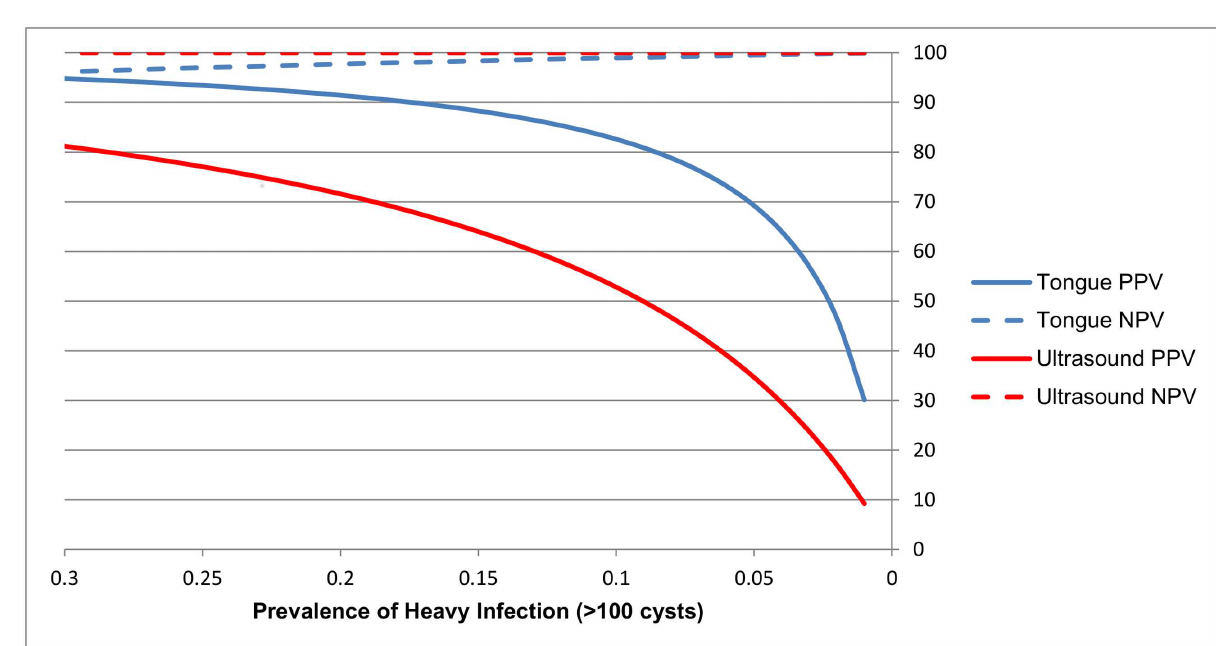
Fig 2. Positive and negative predicted values for the detection of heavily infected pigs ( (cid:21) 100 cysts) with ultrasonography and tongue examination projected across a range of